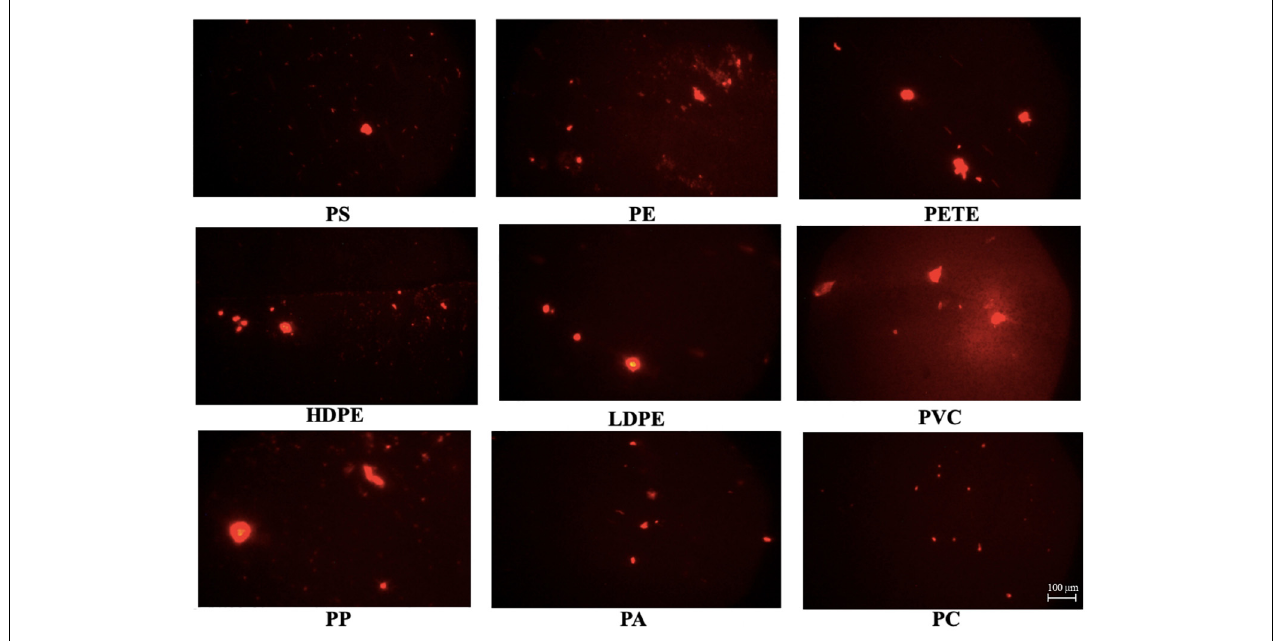
FIGURE 3 | Microscopy photos of stained microplastic polymers at excitation range of 510–560 nm (G2A filter) at 1 min exposure time after 10-min incubation. Scale bar represents 100 µ